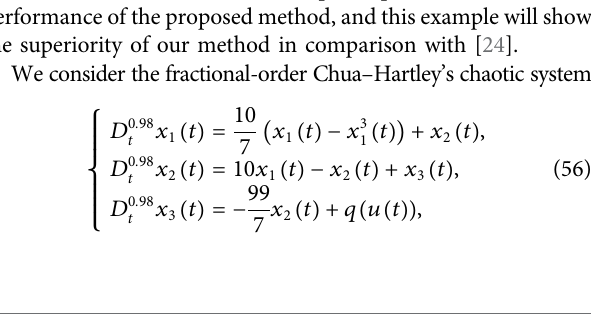
Frontiers in Physics |